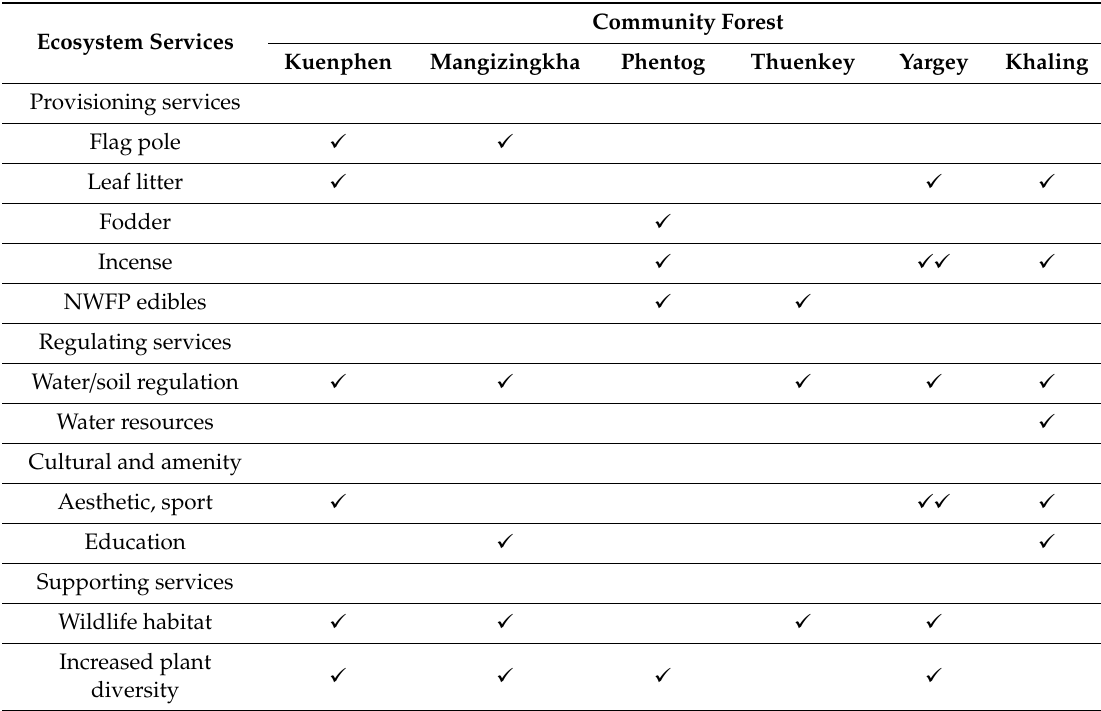
Water/soil regulation